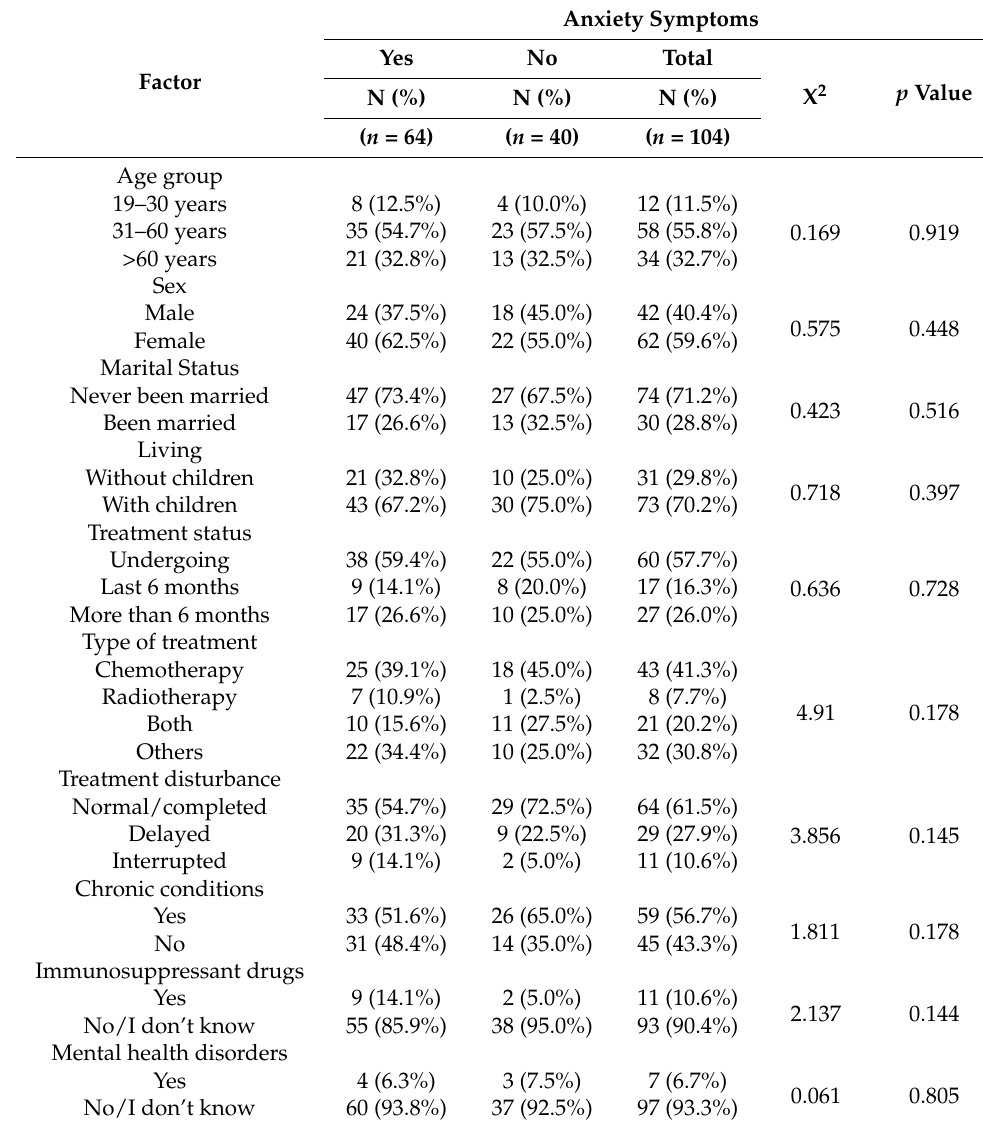
Table 1. Relationship between anxiety symptoms and cancer patient sociodemographic characteristics and treatment plans ( n =